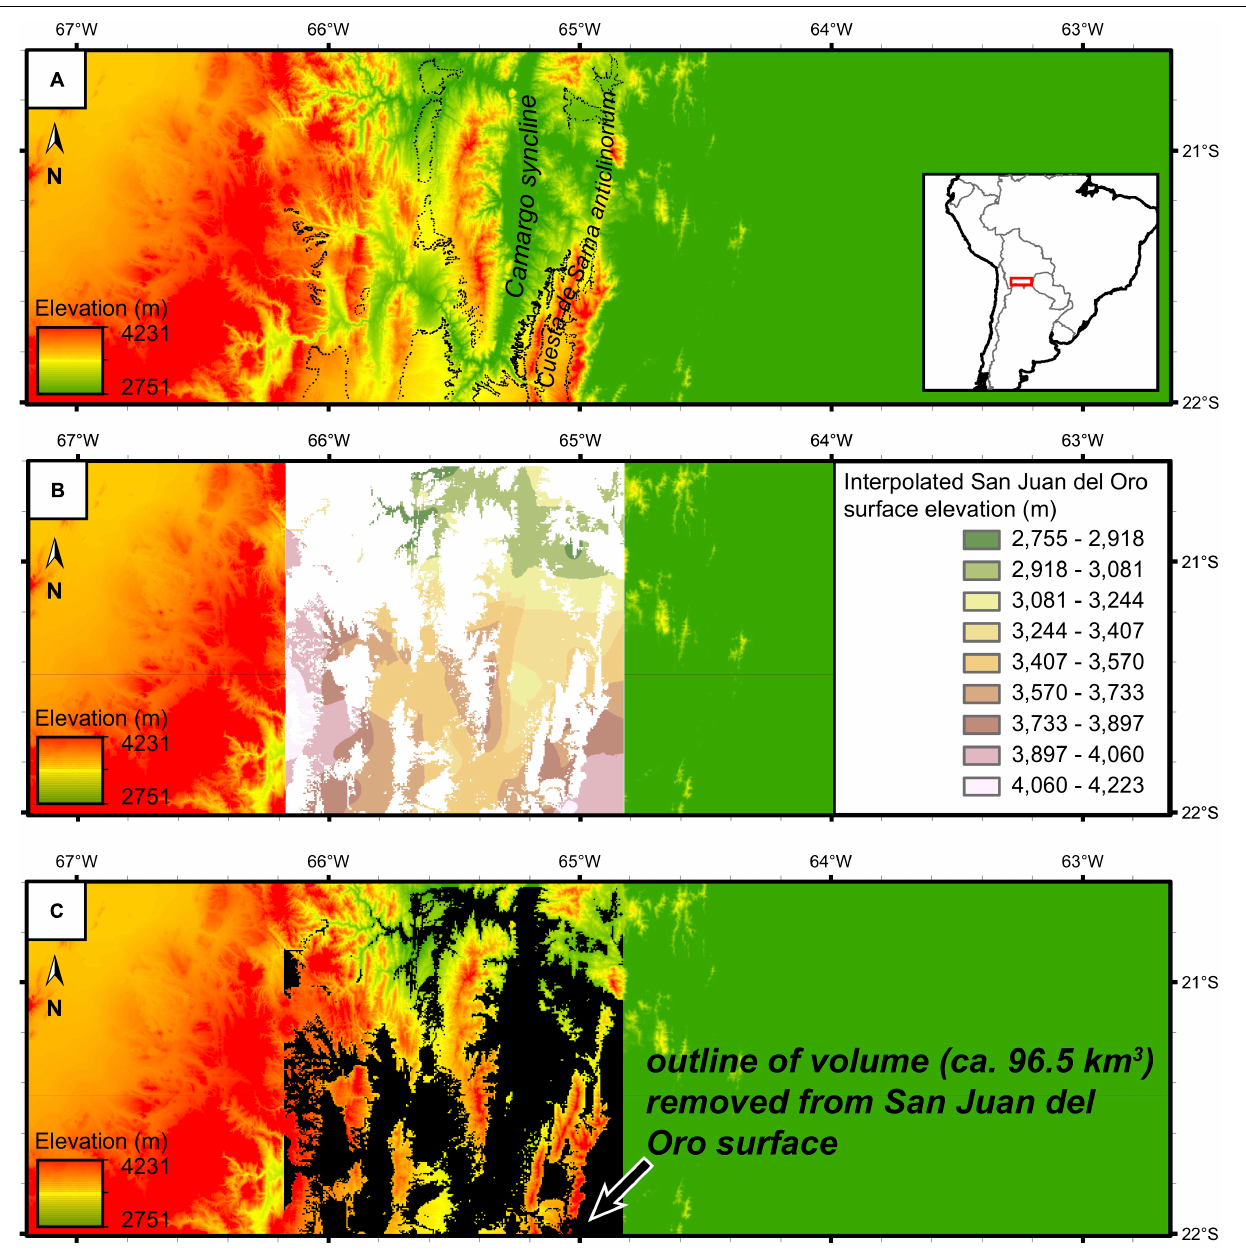
FIGURE 7 | (A) Digital elevation model of the study area showing the control points (black outlined dots) mapped to the boundaries of the high-elevation San Juan del Oro surface. (B) Results from kriging interpolation of the San Juan del Oro control points showing the approximate elevation of the surface prior to erosion. White polygons show regions of positive bedrock relief above the interpolated San Juan del Oro surface. (C) Black polygons show the outline of locations where the DEM is lower than the interpolated San Juan del Oro surface. The volume between the two surfaces (the DEM from A and the kriged surface from B ) is ca. 96.5 km 3